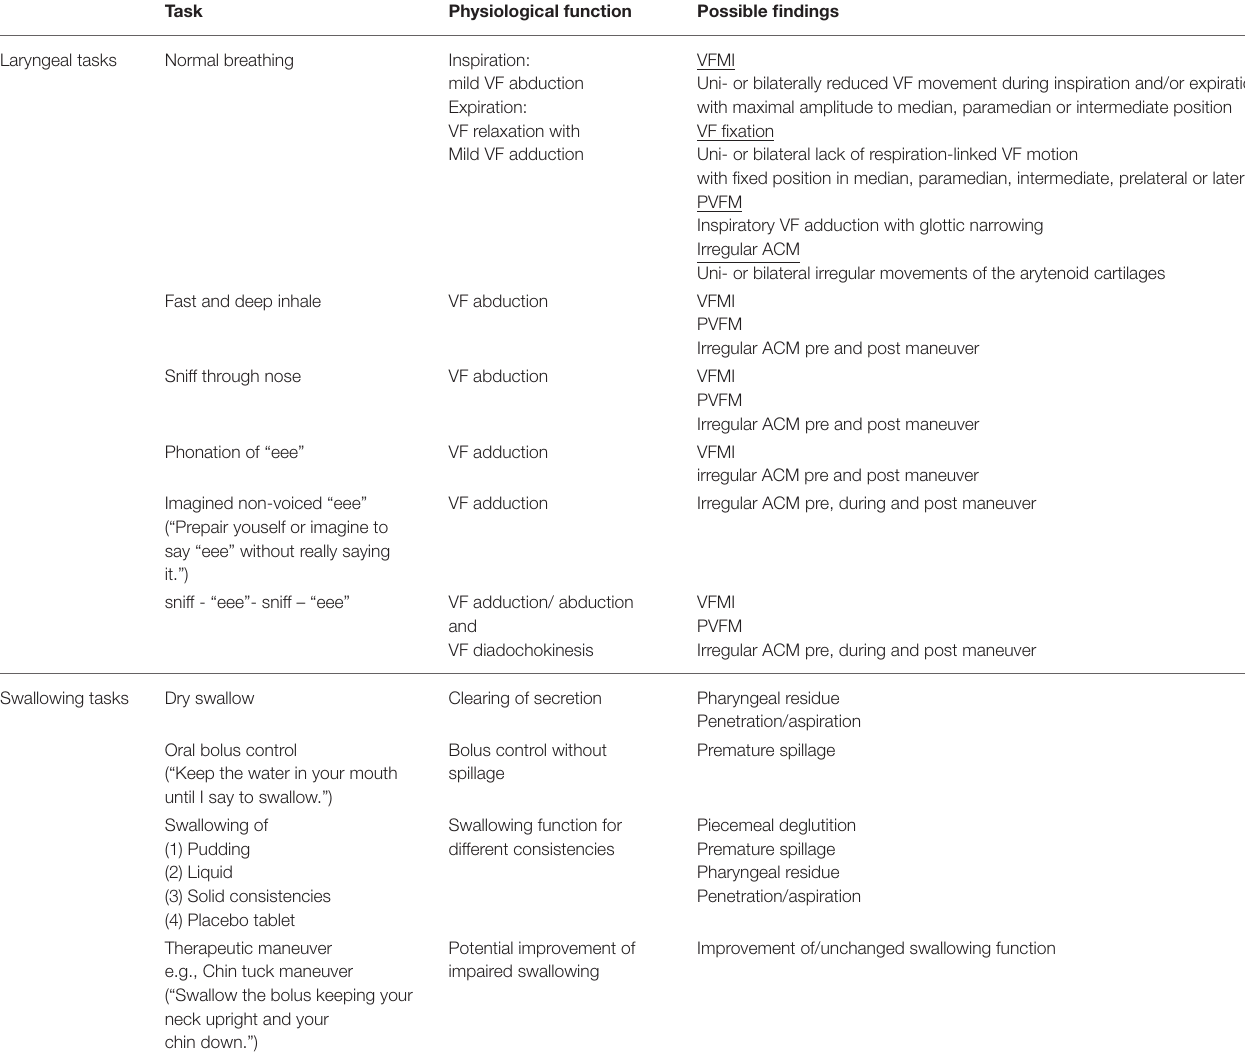
TABLE 2 | Tasks of the FEES-MSA-protocol, assessed functions, and possible